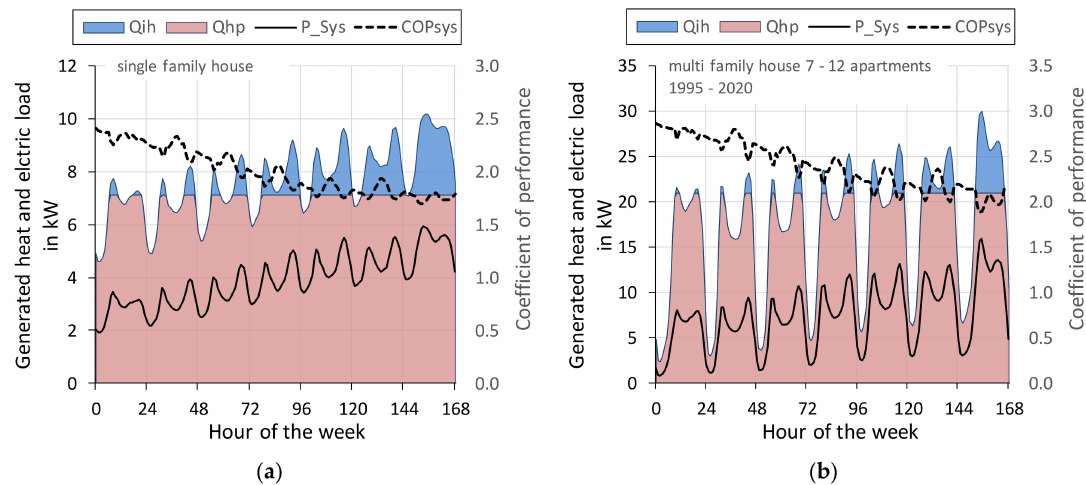
Figure 5. Generated heat, electric load and COP of an air source heat pump system in a single family house before 1979 ( a ) and a multi family house of the building age class 1995–2020 ( b ). Table 1. Characteristic values for air source heat pumps in the two building categories analysed. Building Type Parameter Min Max